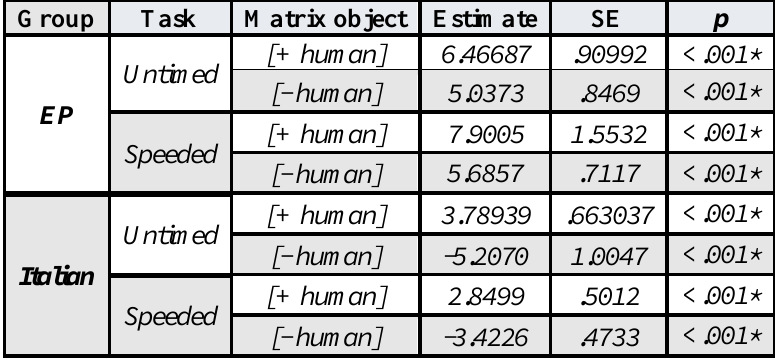
Table 3. Difference between subject and object antecedent assignment in overt pronoun resolution